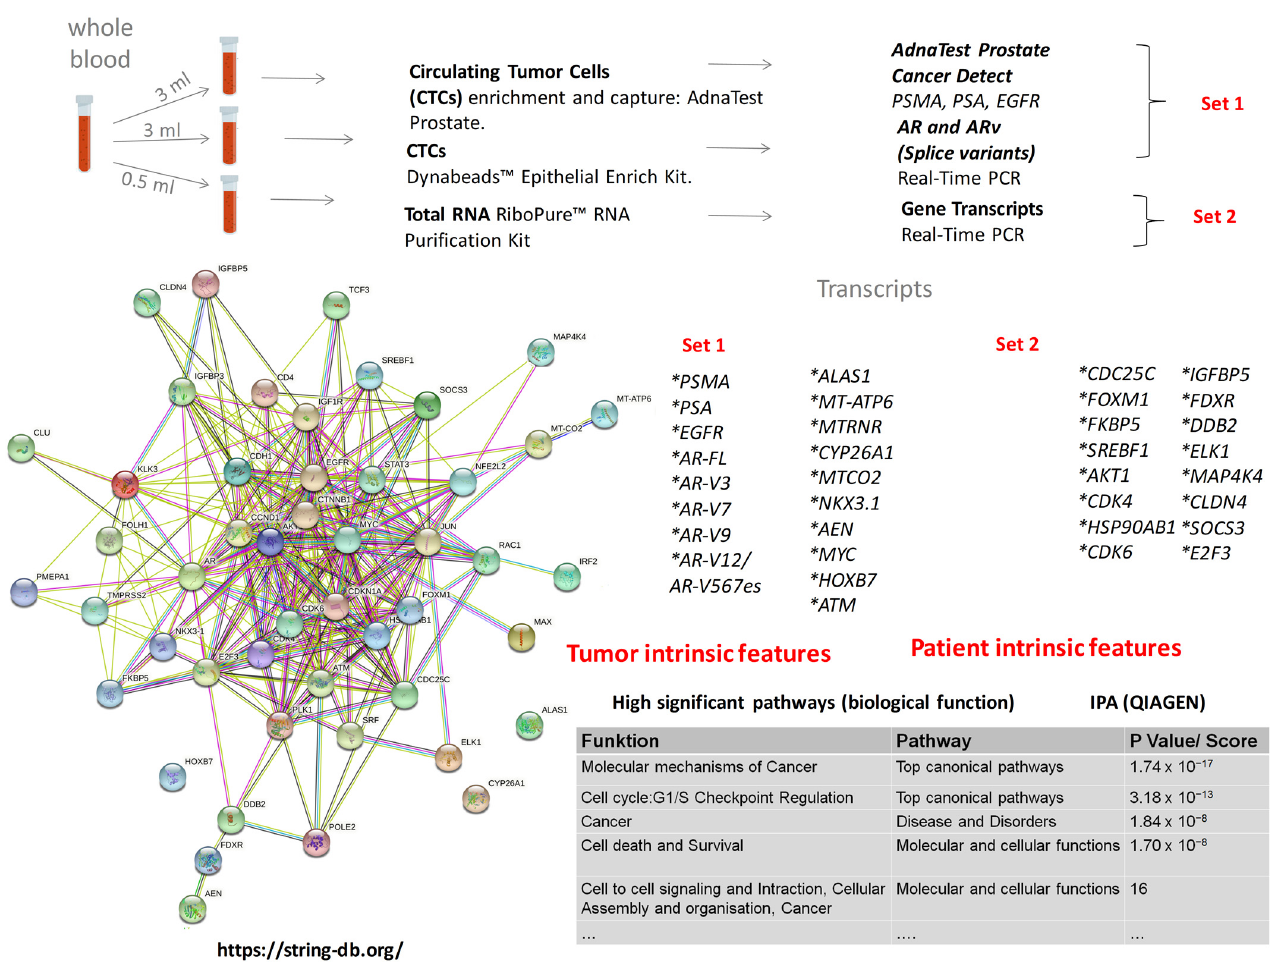
Figure 1. Study workflow. Processing patient blood samples (upper panel), candidate transcripts’ prioritization, and sets of investigated transcripts (lower panel).